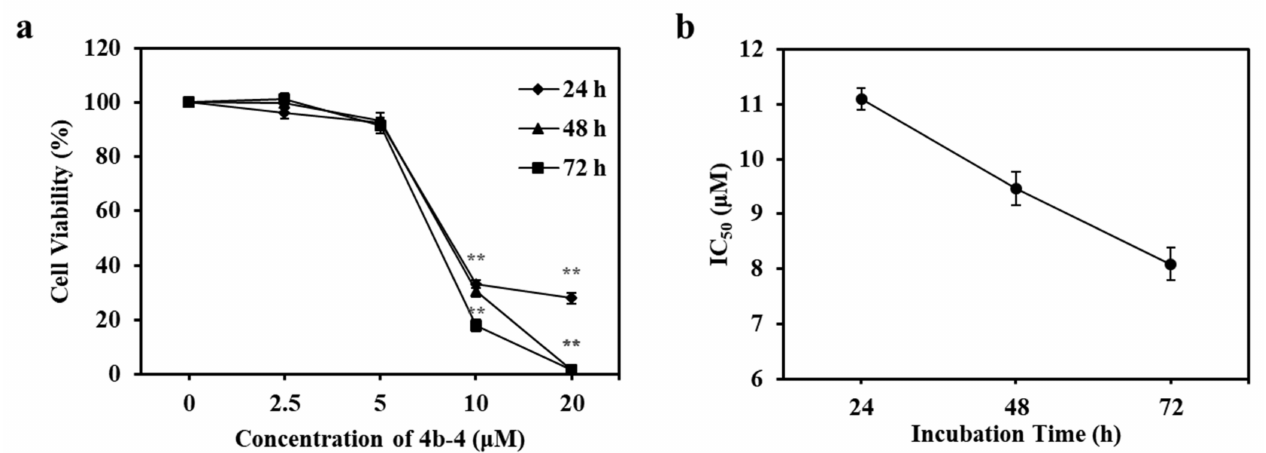
Figure 6. 4b-4 inhibits the viability of K562 cells. ( a ) K562 cells were incubated with different concentration of 4b-4 (2.5–10 µ M) for 24, 48 and 72 h. Then, cell viability (%) was assessed by MTT assay. ( b ) IC 50 values of 4b-4 against K562 cells at 24, 48 and 72 h. Data are presented as mean ± SD for three independent experiments. ** p <